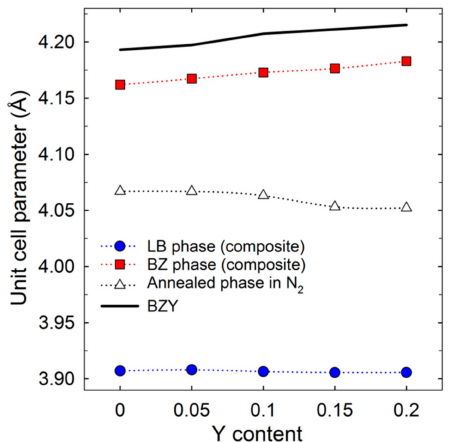
Figure 5. Cubic unit cell parameters at room temperature of the precursor annealed phase (open triangles) and the composite phases (blue and red) obtained by Rietveld refinement. Lines are a guide for the eye. A black line for a yttrium-doped barium zirconate (BZY) cell parameter from the literature is included for comparison